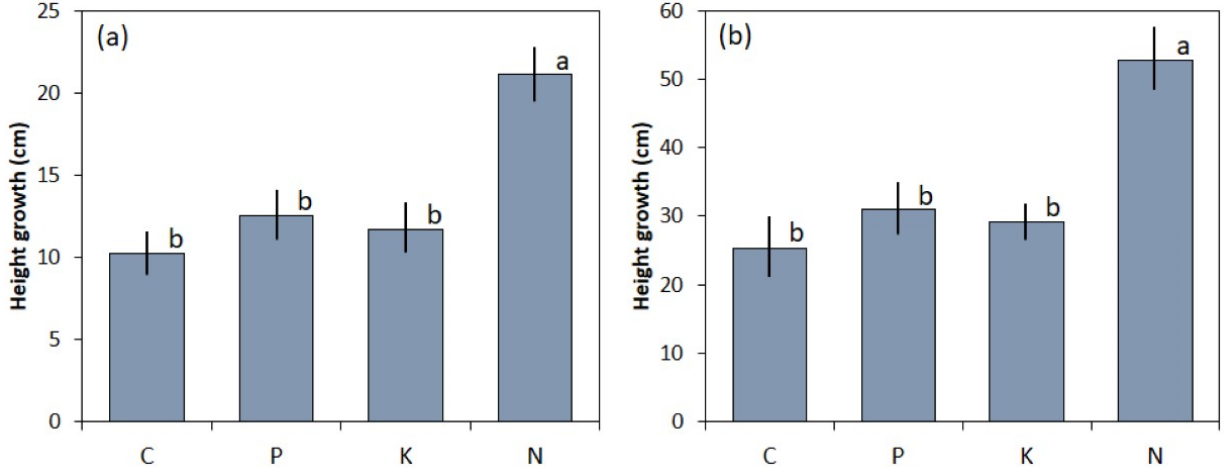
Figure 2. Growth in height of Serianthes plants influenced by phosphorus (P), potassium (K), or nitrogen (N) fertilization in relation to control (C) plants. ( a ) Serianthes nelsonii ; ( b ) Serianthes grandiflora . Means ± standard error, n = 6. Bars with same letters are not different.